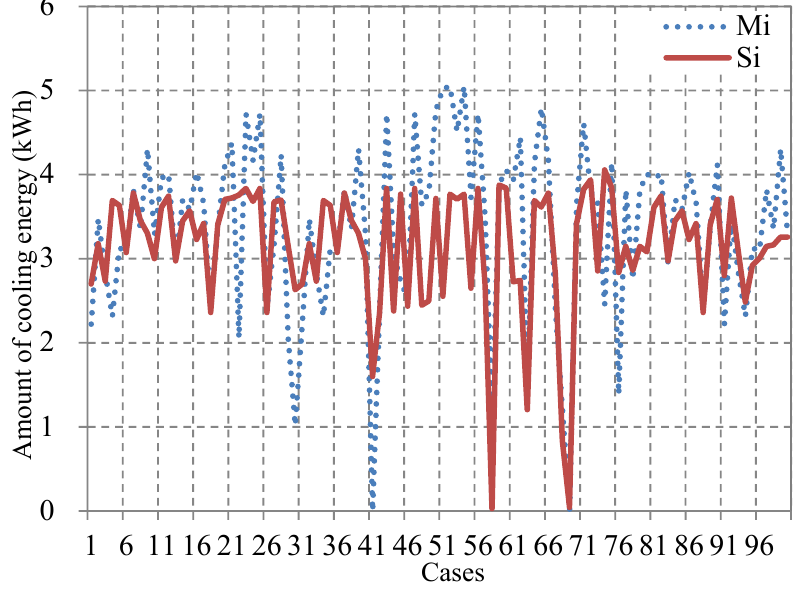
Figure 10. Comparison of the simulated results with the prediction